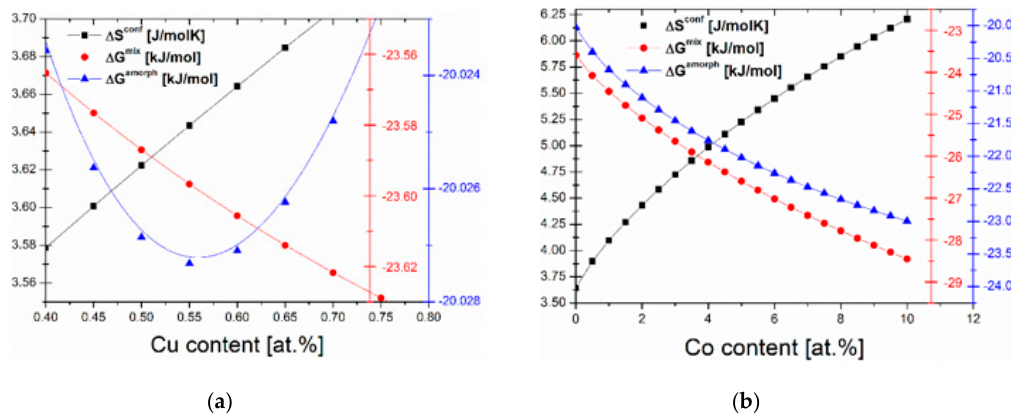
Figure 1. The thermodynamic parameters dependences in the function of Cu (Fe 86 − y Cu y B 14 ) ( a ) and Co (Fe 8 5.45 − x Co x Cu 0.55 B 14 ) ( b ) content. Co (Fe 85.45 − x Co x Cu 0.55 B 14 ) ( b )